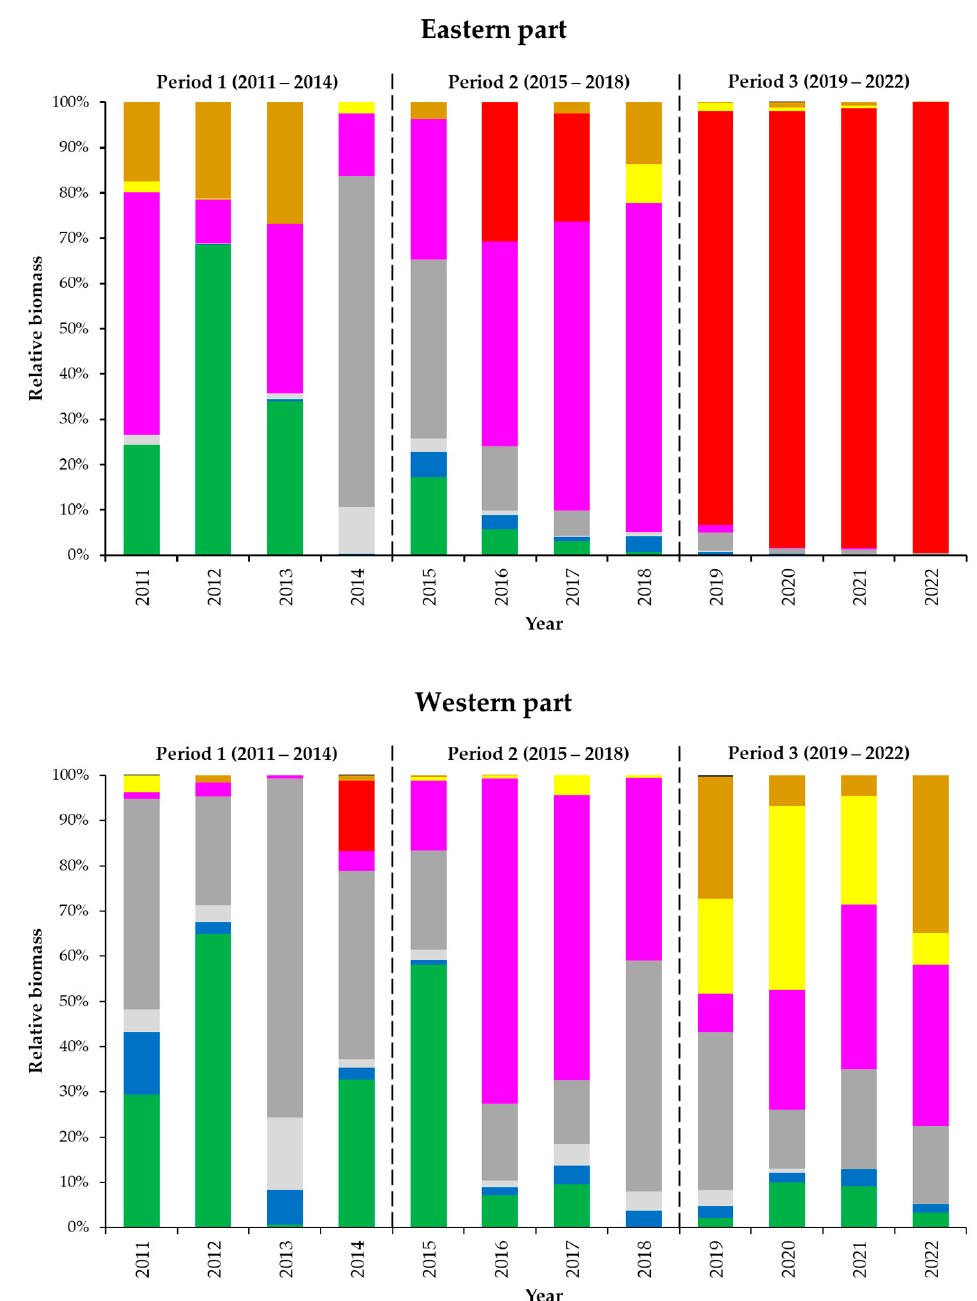
Figure 4. Average composition (in terms of biomass of three samples) of invertebrates per year in the eastern and western sections of DWDS Zeeuws-Vlaanderen. (cid:4) : Chydoridae; (cid:4) : Halacaridae; (cid:4) : Nauplius larvae of copepods; (cid:4) : Cyclopoida; (cid:4) : Harpacticoida; (cid:4) : Asellus aquaticus ; (cid:4) : Turbellaria; (cid:4) : Oligochaeta; (cid:4) : other (not identified) invertebrates.